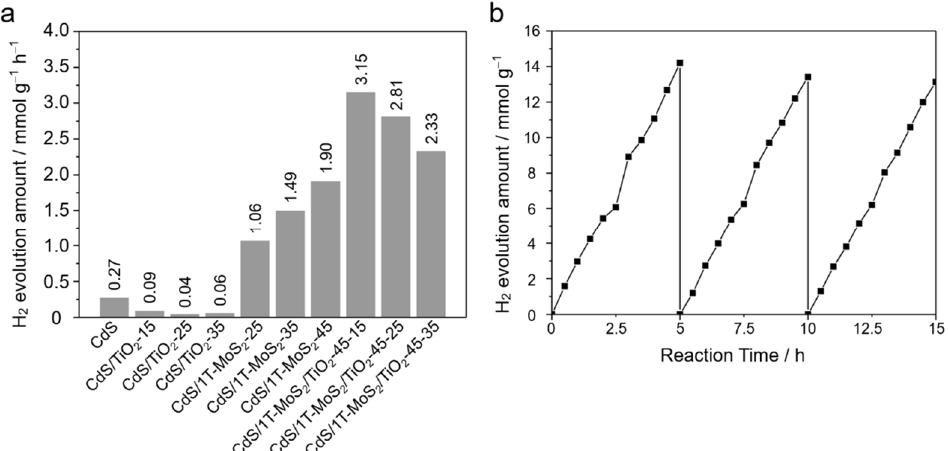
Figure 4. ( a ) Total amount of photocatalytic hydrogen production in 3 h of the bare CdS, binary, and ternary heterojunctions. ( b ) Hydrogen production cycle test of ternary CdS/1T-MoS 2 /TiO 2 -45- 15.